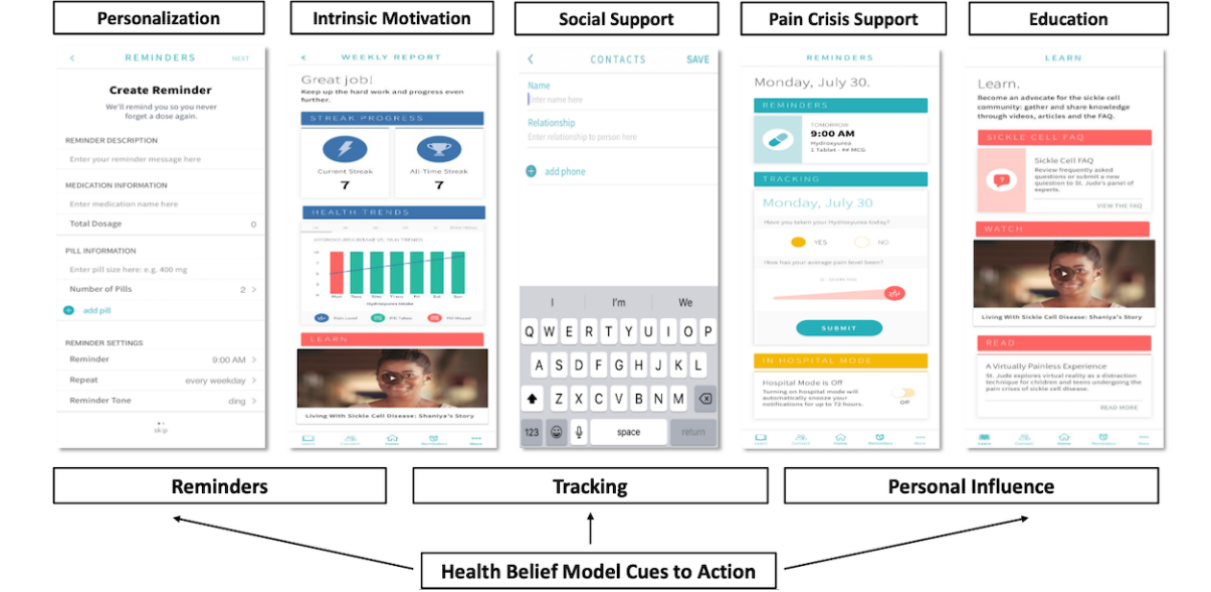
Figure 2. Screenshots of different functions in InCharge Health App mapped to health belief